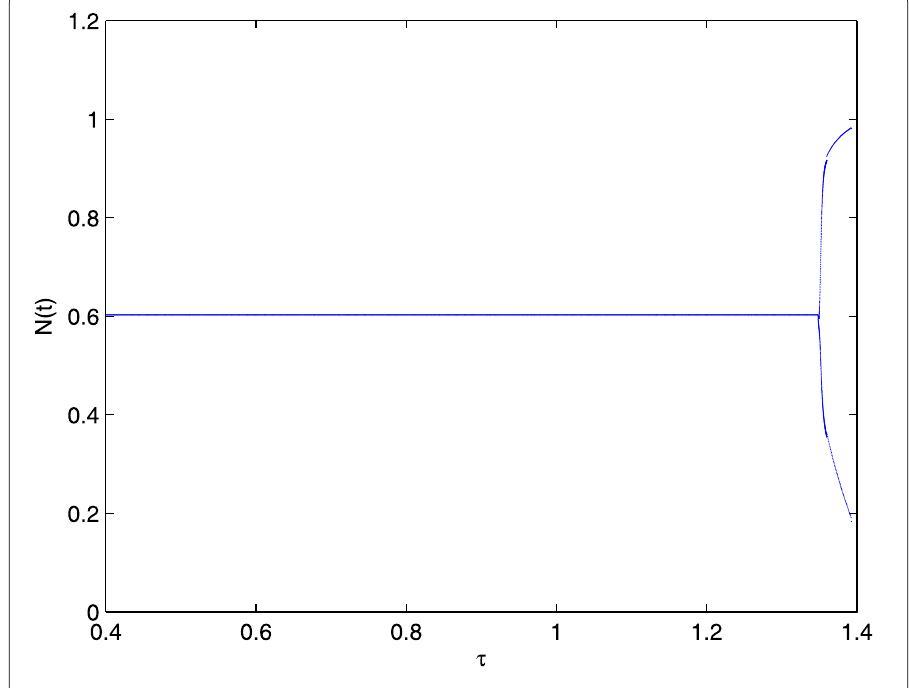
When v = –0.005, the eigenvalues of system (3) are –0.529, –14.591; when v =